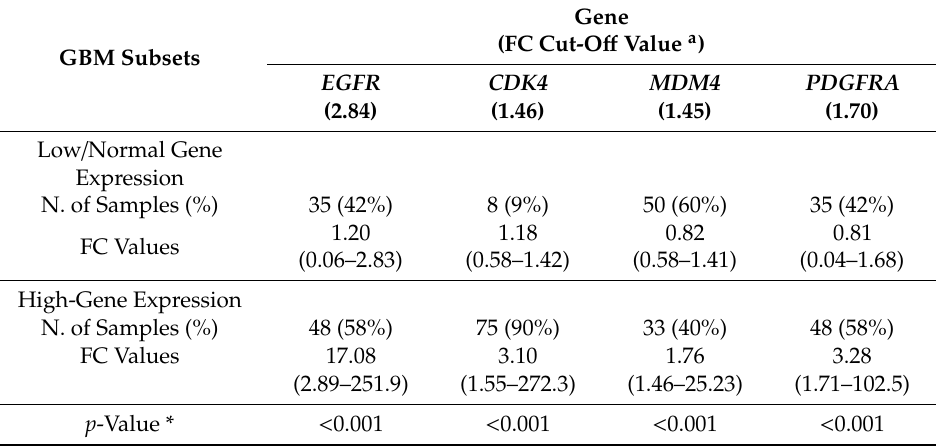
Table 2. Distribution of GBM according to the gene expression profiles (GEP) observed for the EGFR , CDK4 , MDM4 , and PDGFRA